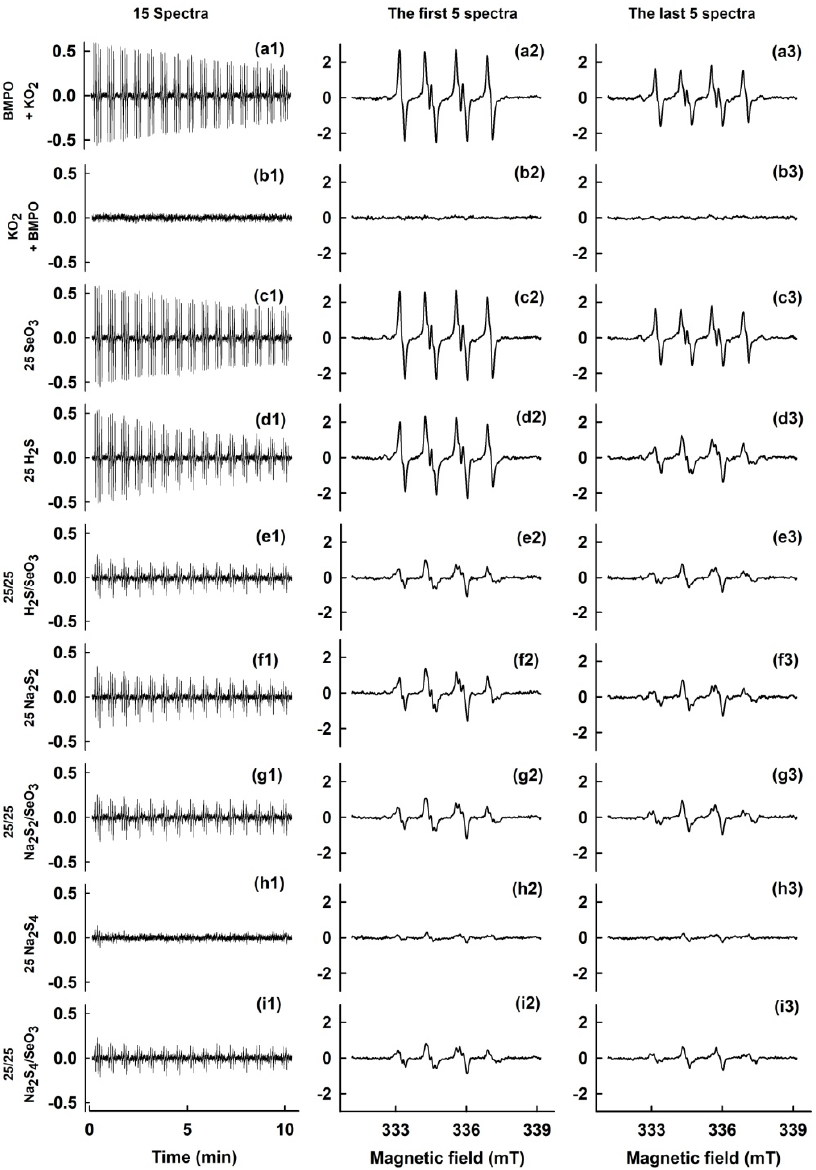
Figure 1. Electron paramagnetic resonance (EPR) spectra of • BMPO-OOH modulated by Na 2 S, Na 2 S 2 , Na 2 S 4 and their interaction with SeO 32 . ( a1 – i1 ) Collection of 15 EPR spectra arranged back-to-back